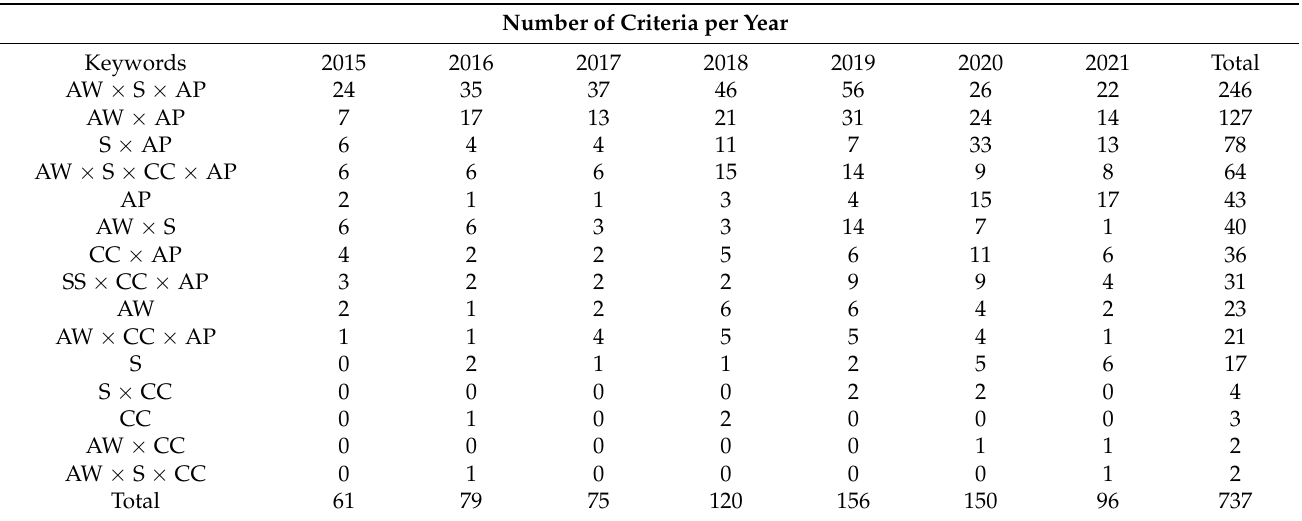
Table 1. Column graphs showing number of articles that included one or more of the key factors factor (Animal Welfare— AW, Stress—S, Climate Change—CC, Animal Production—AP) in their research between 2015–2021.